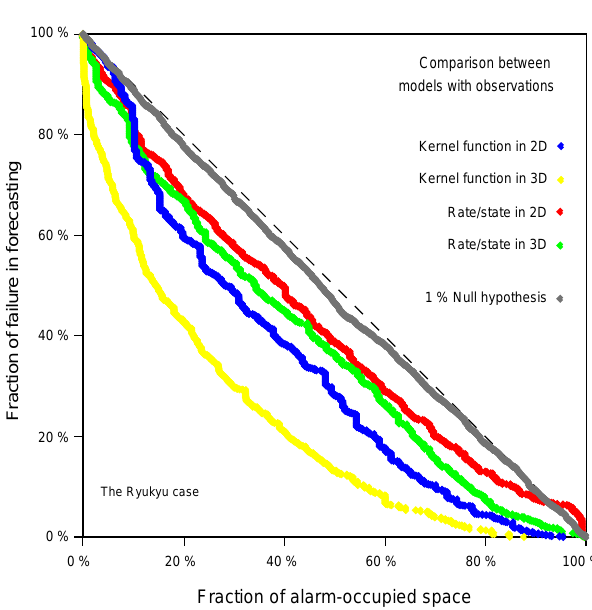
Figure 8. The Molchan diagram used for investigating the correla- tion between different forecasting models and earthquakes during the forecasting period (2010–2011) for the Ryukyu case. Blue and yellow dots represent the results for the models using the smooth- ing kernel models in two- and three-dimensional grids, respectively; red and green dots represent the results for the models using the rate-and-state friction models in two- and three-dimensional grids, respectively; grey dots represent the 99% significance level deter- mined by 1640 forecasting